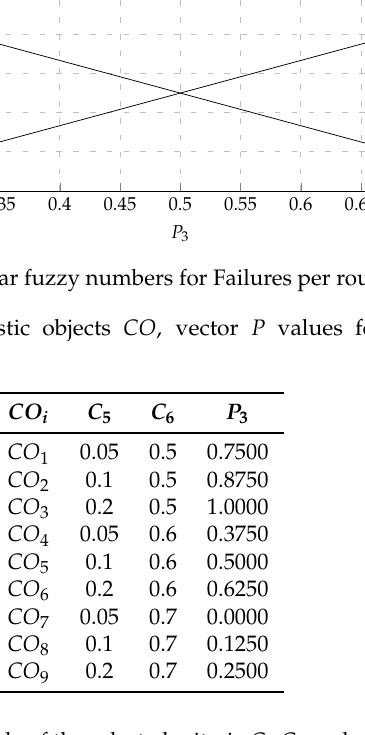
Table 8. The performance table of the selected criteria C 5 , C 6 and assessment model P 3 .